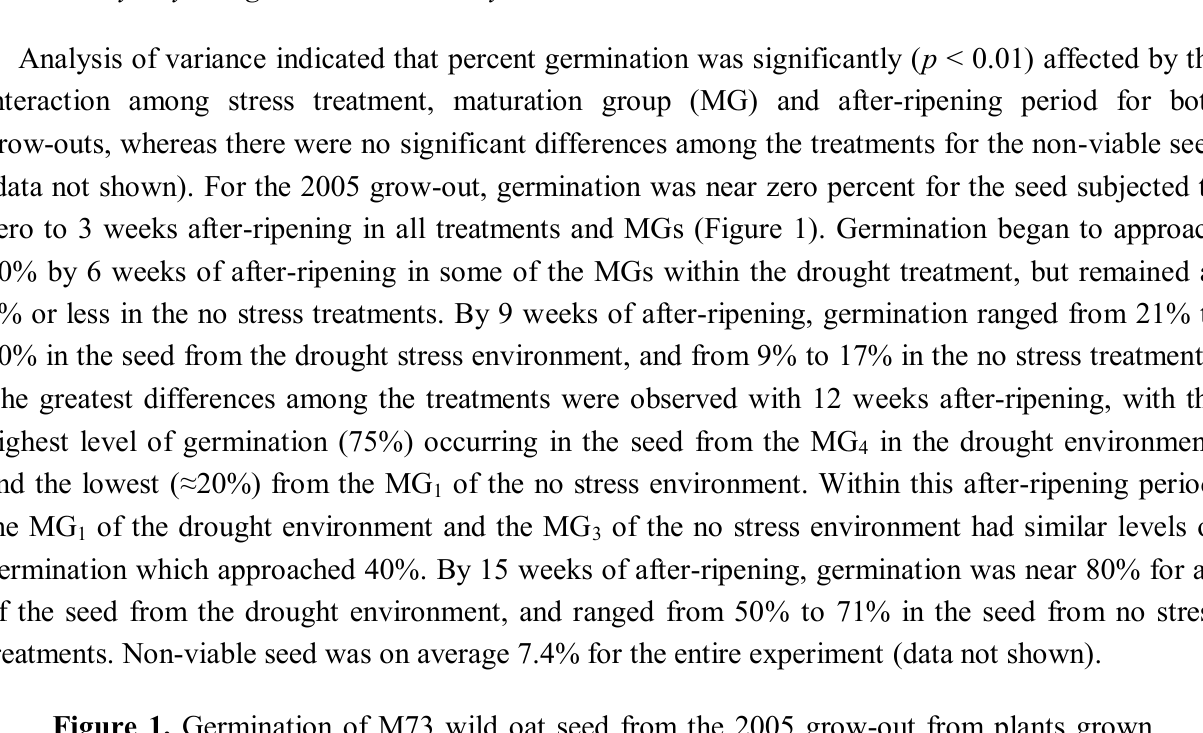
Figure 1. Germination of M73 wild oat seed from the 2005 grow-out from plants grown under well-watered (no-stress) and drought conditions after being subjected to varying durations of controlled